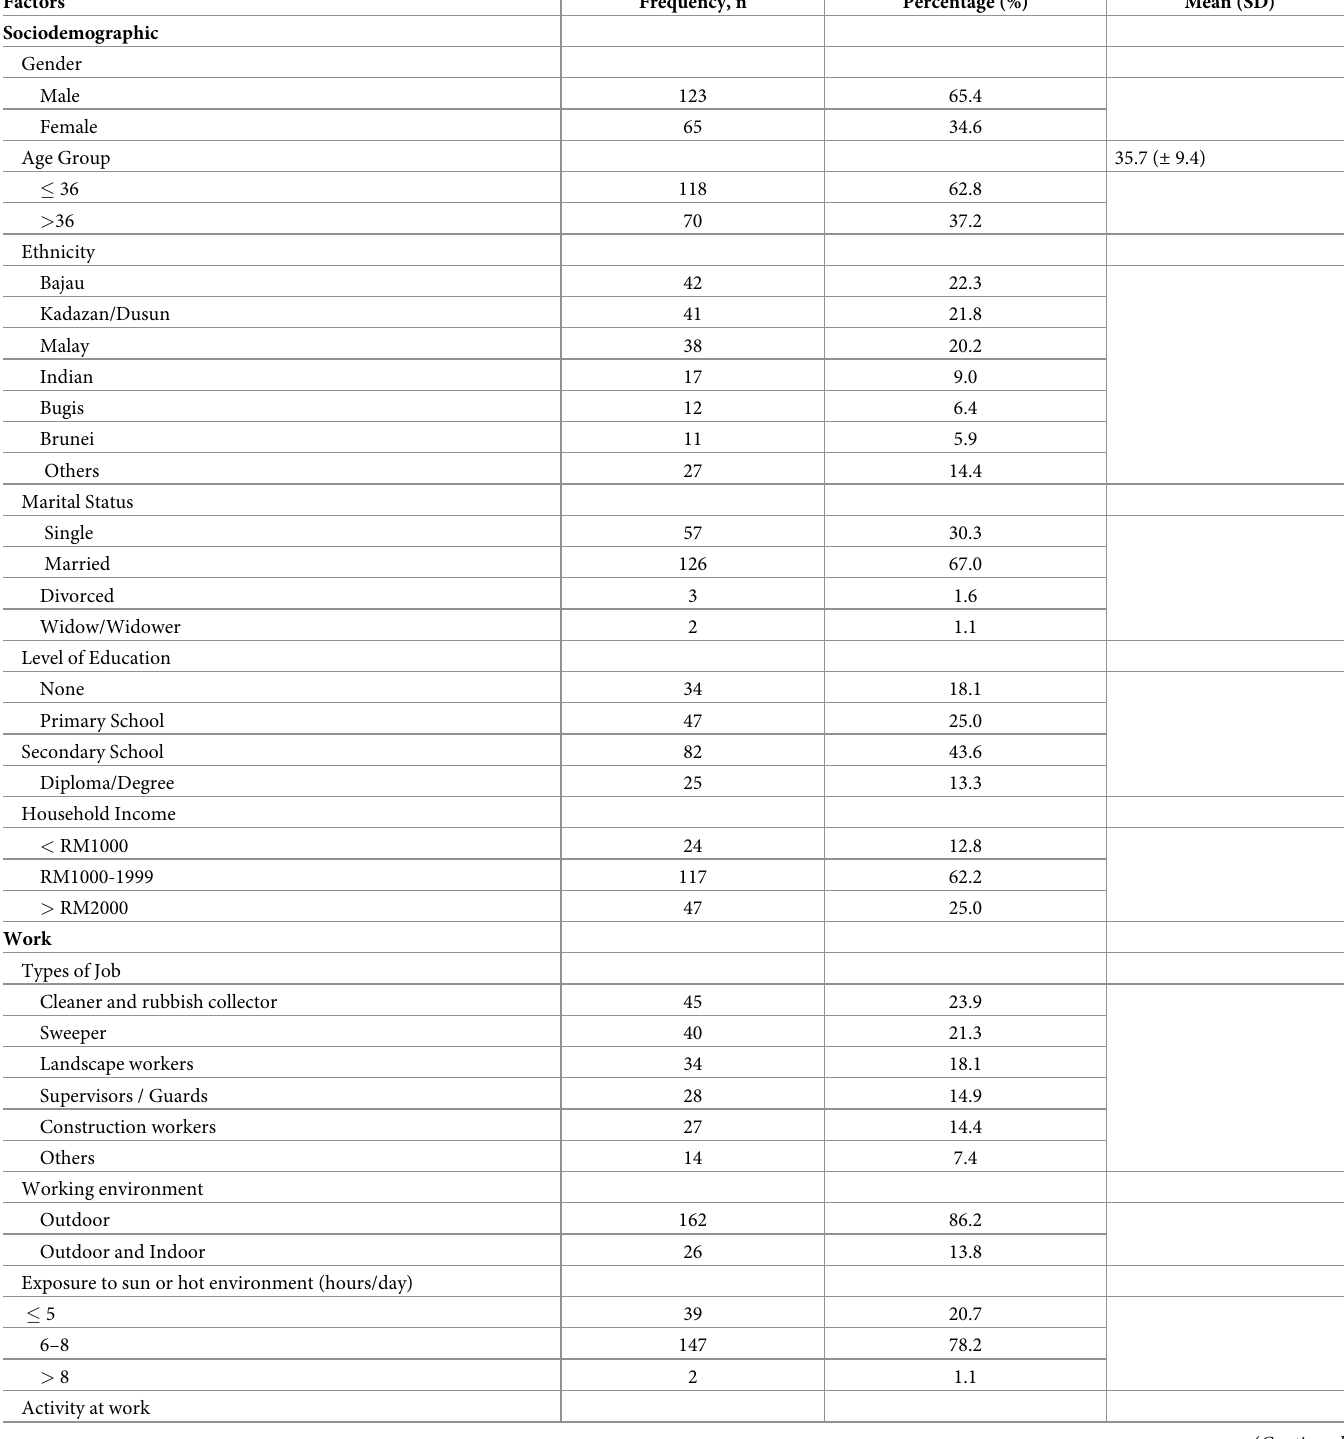
Table 4. Summary distribution of the sociodemographic and work characteristics of outdoor workers for field study (N =